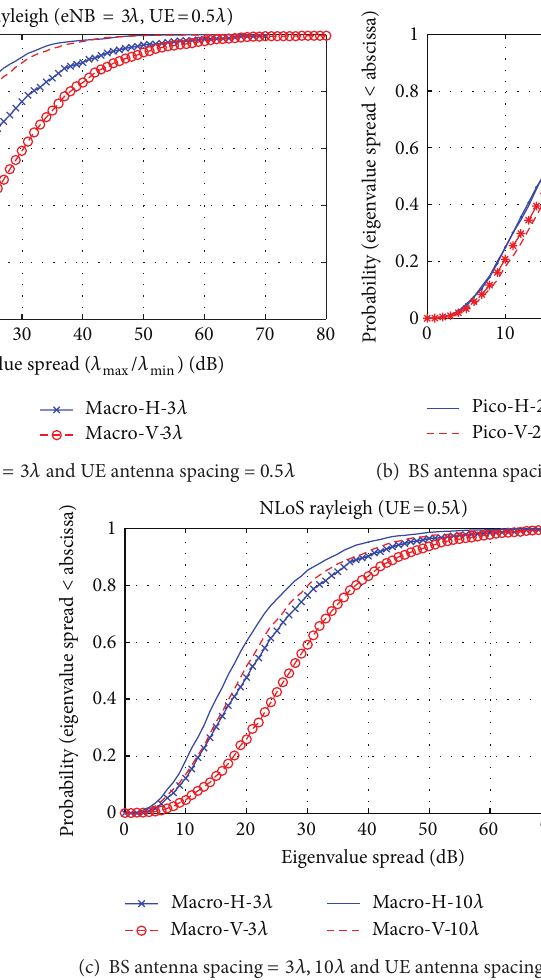
Figure 13: The CCDF of eigenvalue spread performance of picocells and macrocells in horizontal and vertical eNB antenna array configurations (NLoS links